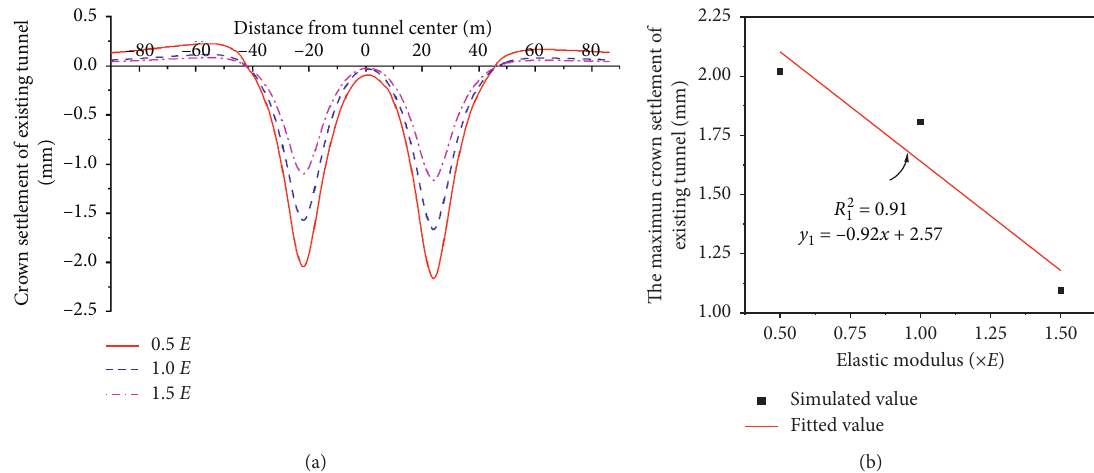
Figure 15: The influence of soil elastic modulus on the crown settlement of existing tunnel. (a) The settlement curves of the existing tunnel. (b) The linear fitting of the maximum settlement value of the existing tunnel.